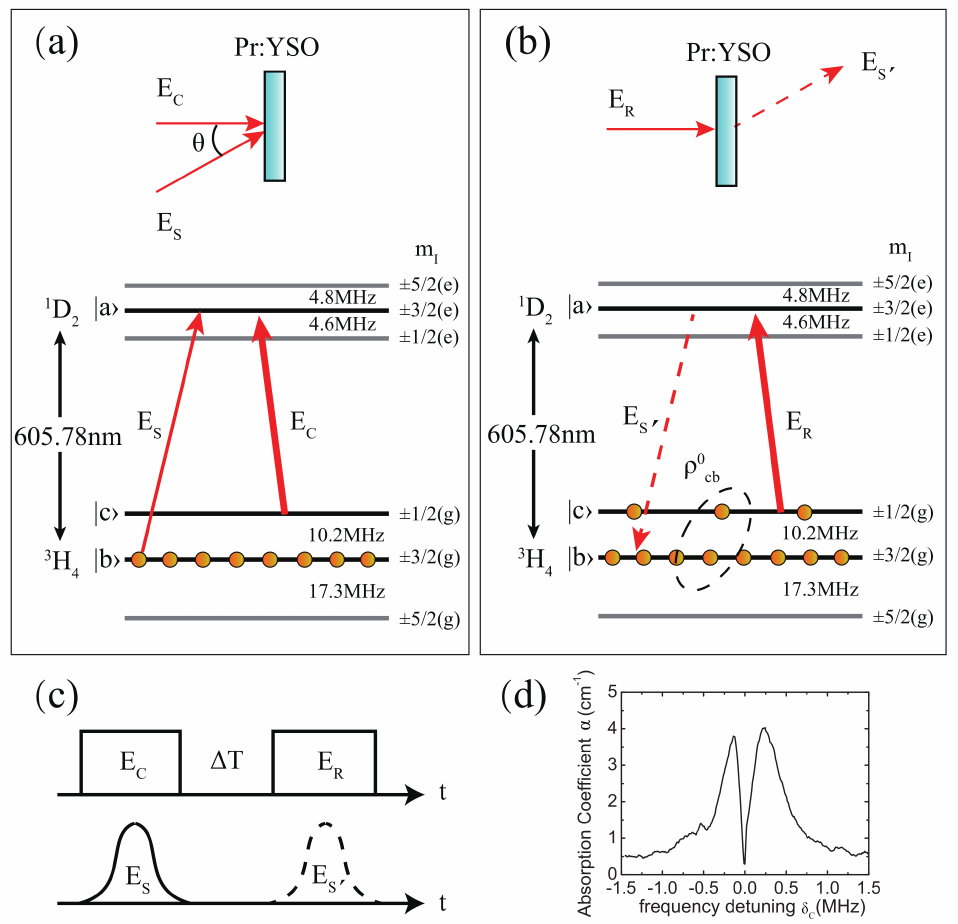
Figure 2. The schematic diagram of the light pulse storage and retrieval based on the EIT effect. ( a ) shows the storage process of light pulses in the form of atomic coherence grating at the two ground levels, | b (cid:105) and | c (cid:105) , and ( b ) shows the retrieval process of the light pulse, E S (cid:48) , by launching a readout beam, E R . The solid circles indicate the populations of | b (cid:105) and | c (cid:105) . The schematic temporal traces of the involved optical fields are shown in ( c ), where the upper lines indicate the on and off states of the coupling light pulse, E C , and the readout light pulse, E R , and the pulses in the bottom row represent the signal light pulse, E S , and the retrieved light pulse, E S (cid:48) , respectively. ∆ T is the storage time of the signal pulse in Pr:YSO crystal. The absorption spectrum of Pr:YSO crystal near the two-photon resonant condition is shown in ( d ). Figure 2d was adapted from reference